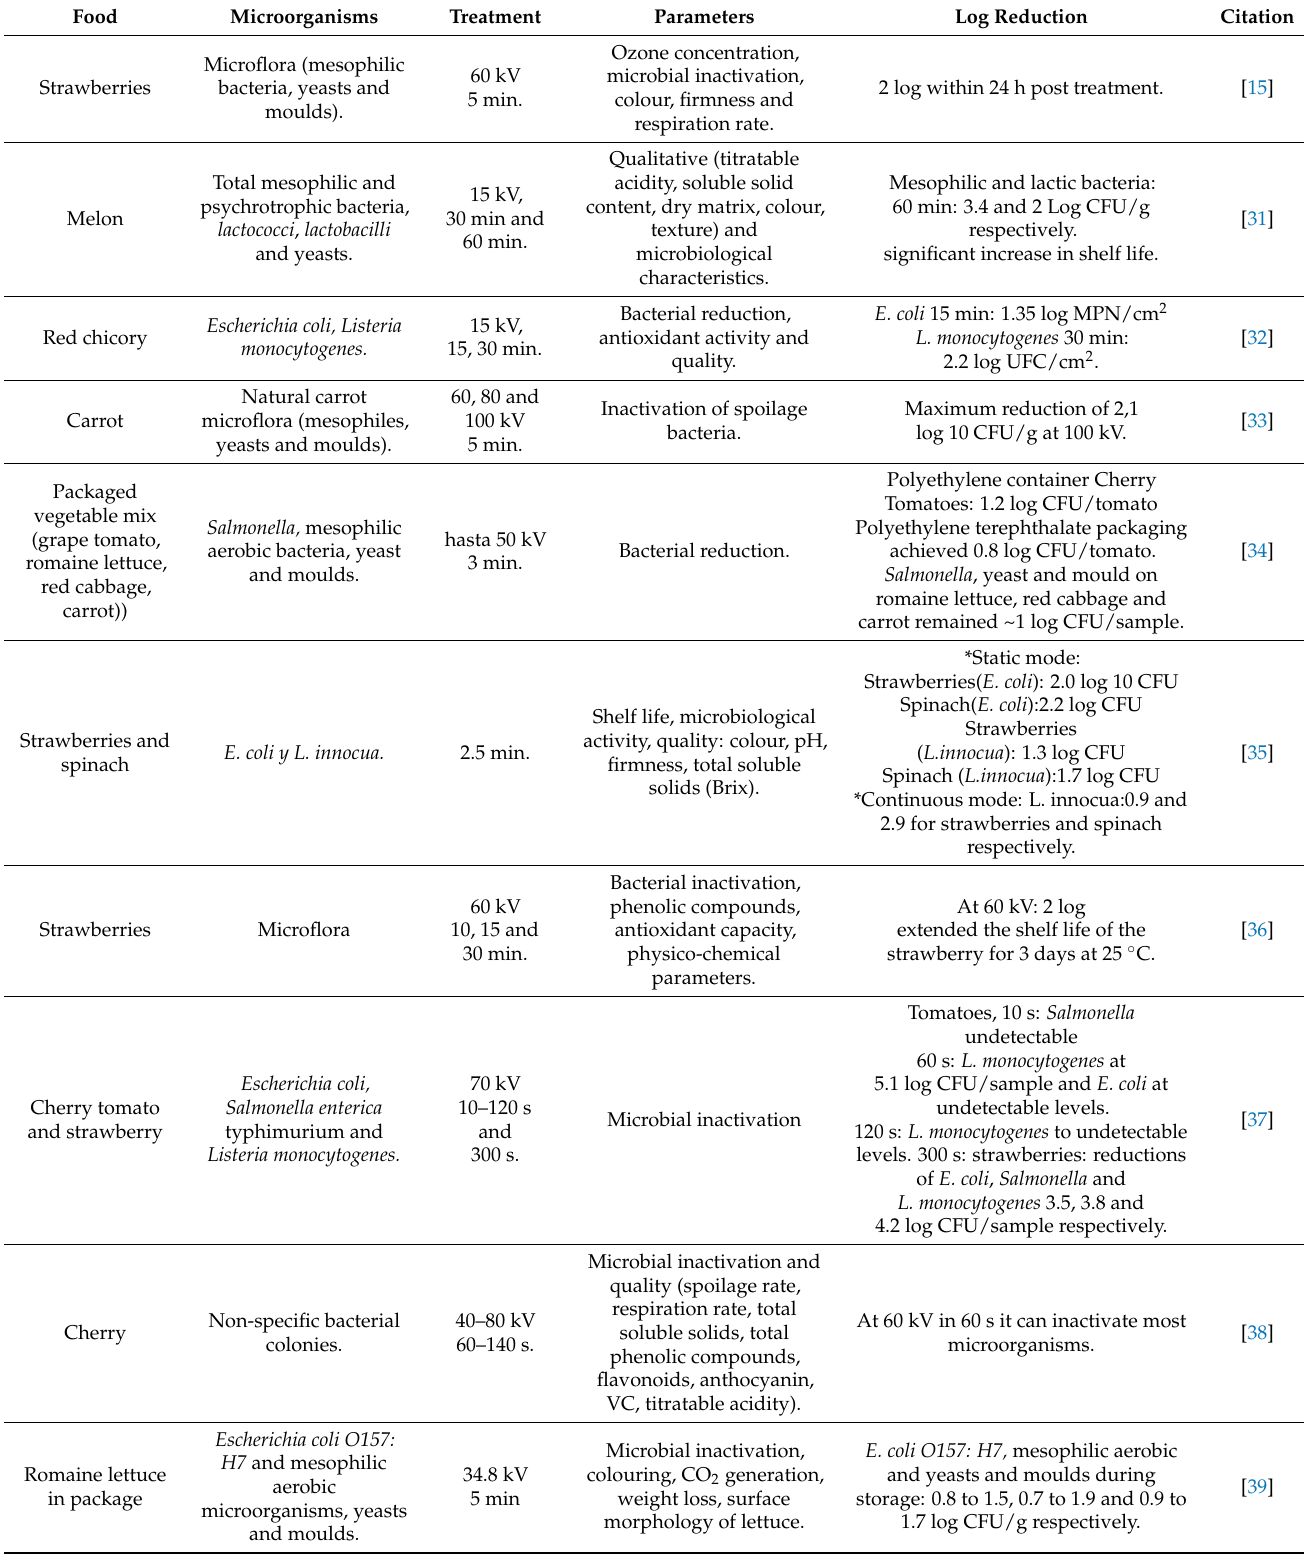
Table 2. Fruits and vegetables treated with DBD at atmospheric pressure and